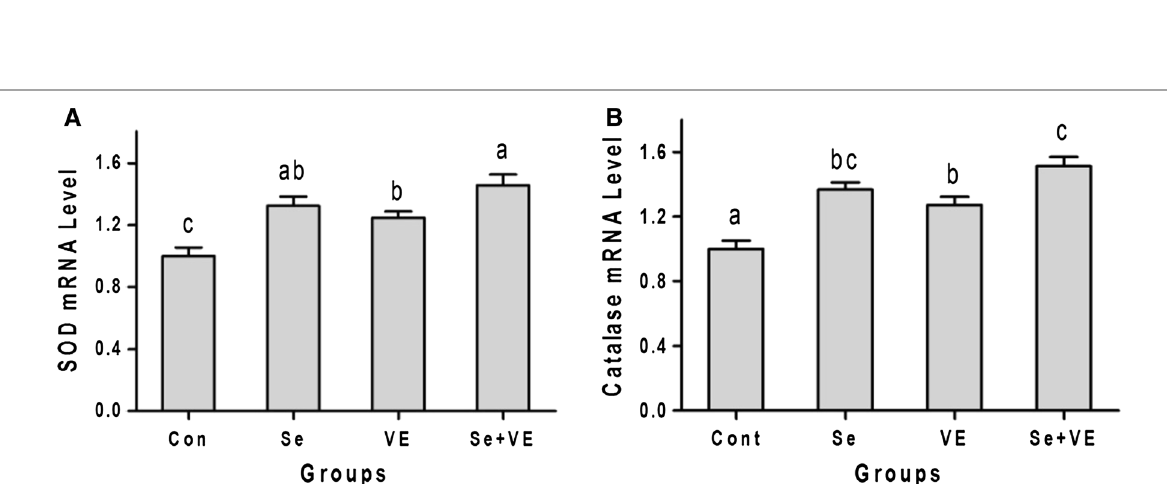
Fig. 5 Effects of Se, VE and Se VE on relative mRNA level of A SOD and B catalase in breast muscles of heat stressed broiler chickens. Mean values + with their standard errors. The values with unlike superscript letters (a, b, c) in the graph were different (P <